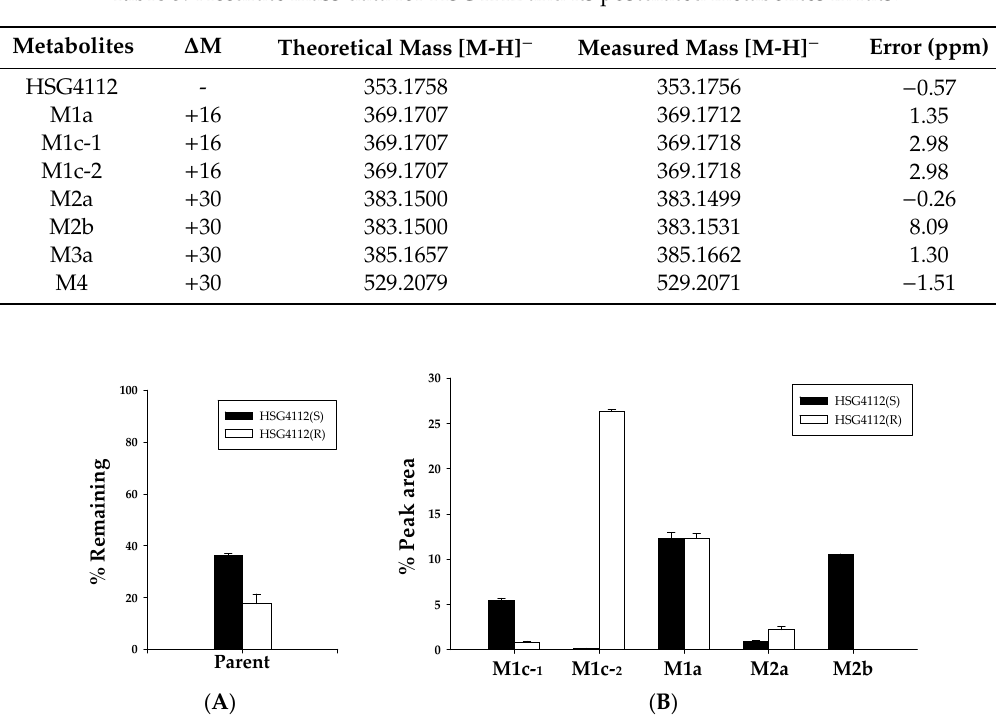
Table 5. Accurate mass data for HSG4112 and its postulated metabolites in rats.